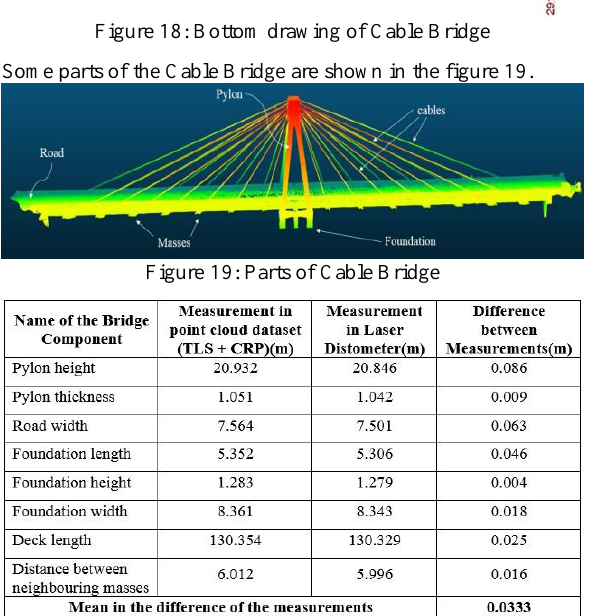
Figure 17: Side drawing of Cable Bridge